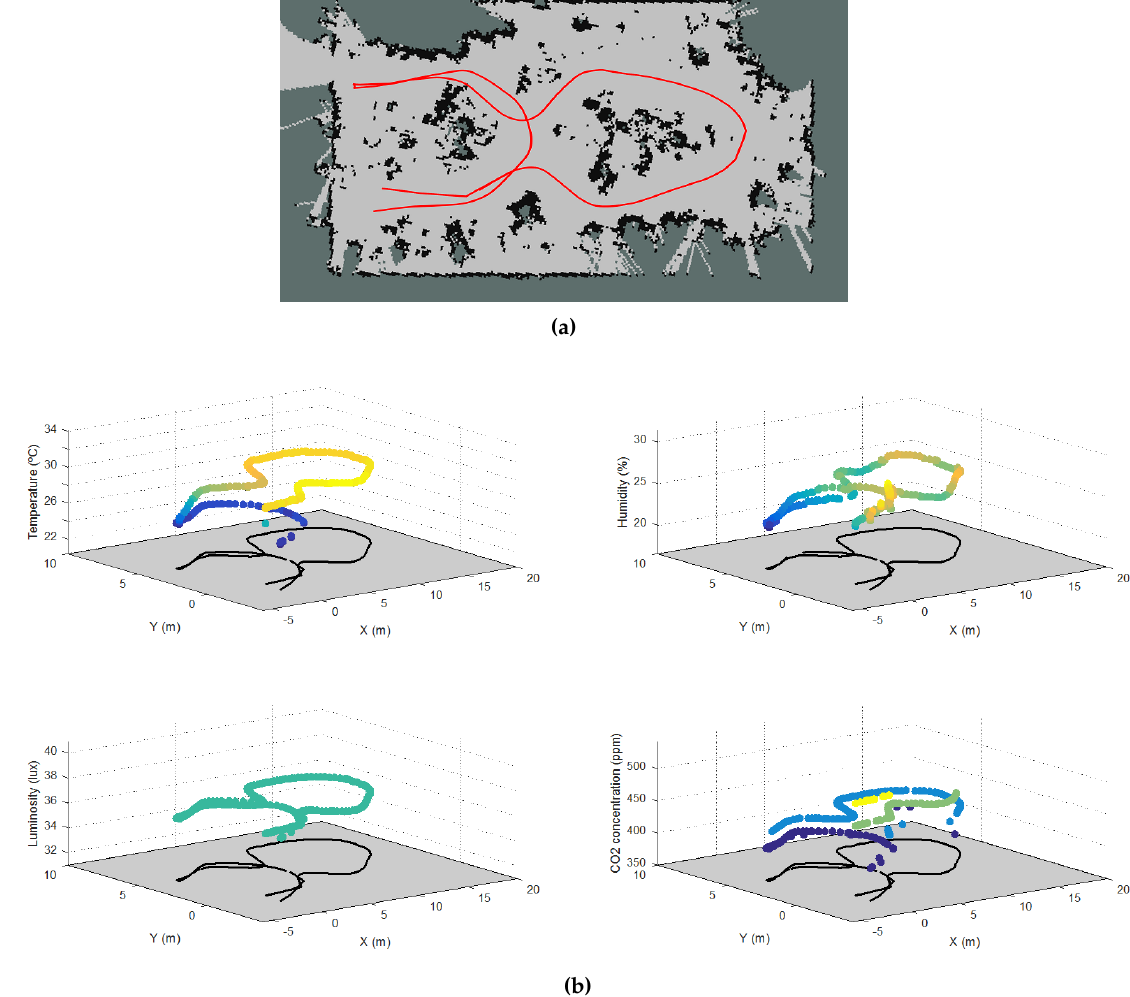
Figure 14. Mapping of the environmental variables of greenhouses: ( a ) Ground robot path in the greenhouse; ( b ) Distribution of temperature, humidity, luminosity and CO 2 concentration in the